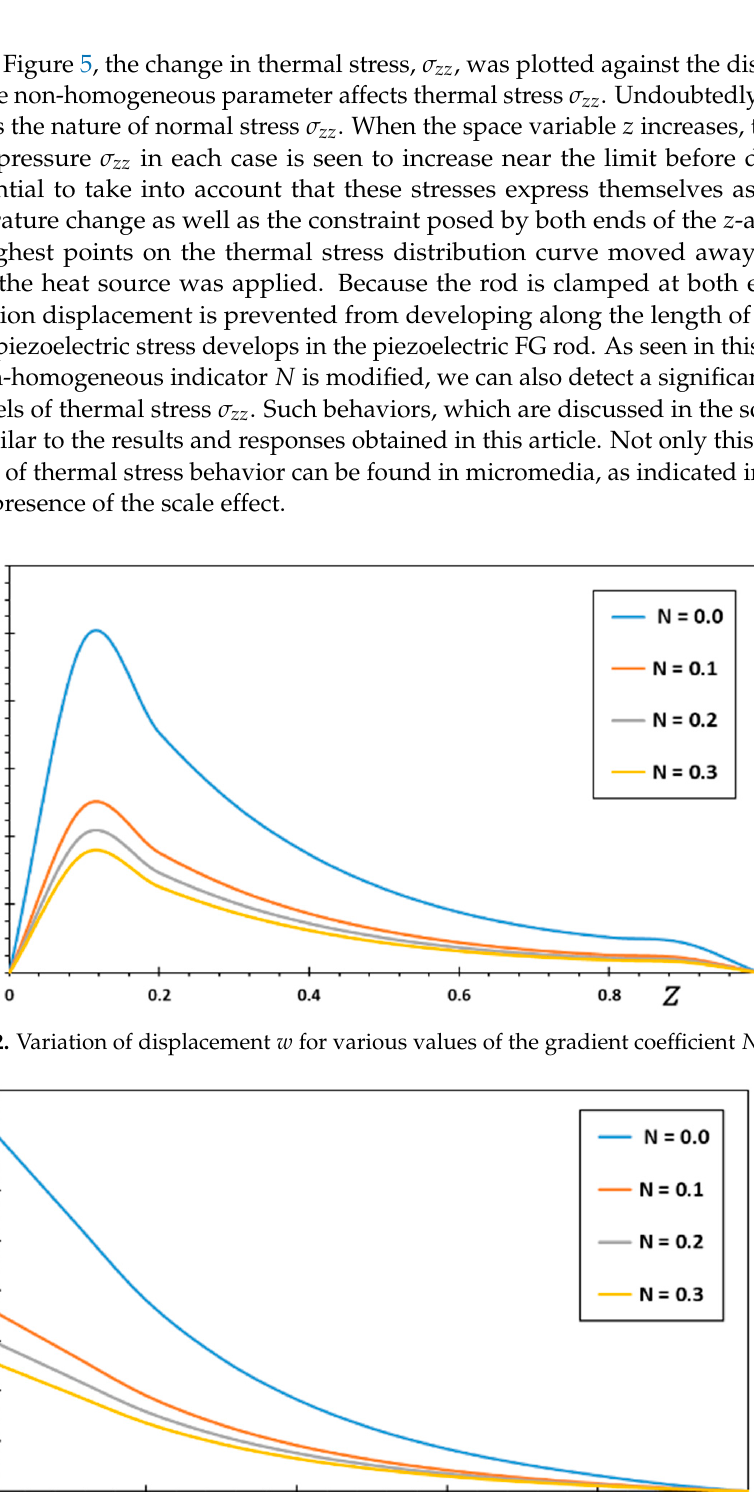
Figure 4. Variation of electric potential 𝜑 for various values of the gradient coefficient 𝑁 . Figure 5. Variation of thermal stress 𝜎 (cid:3053)(cid:3053) for various values of the gradient coefficient 𝑁 . 7. Conclusions The goal of this work was to show that the DPL heat conduction model can be used to describe how the temperature changes in functionally graded piezoelectric thermal me- dia. This model makes it easier to predict how these materials will react to heat and how they will behave when they are in two phases. This model has a different advantage over other models, in that it can be used to represent the ultra-fast heat transfer process on a small scale. Based on this model, we consider how displacements, stresses, and tempera- tures interact with each other in a functionally graded (FG) piezoelectric finite elastic rod. This FG rod is due to the effect of a moving heat source of uniform intensity while rotating